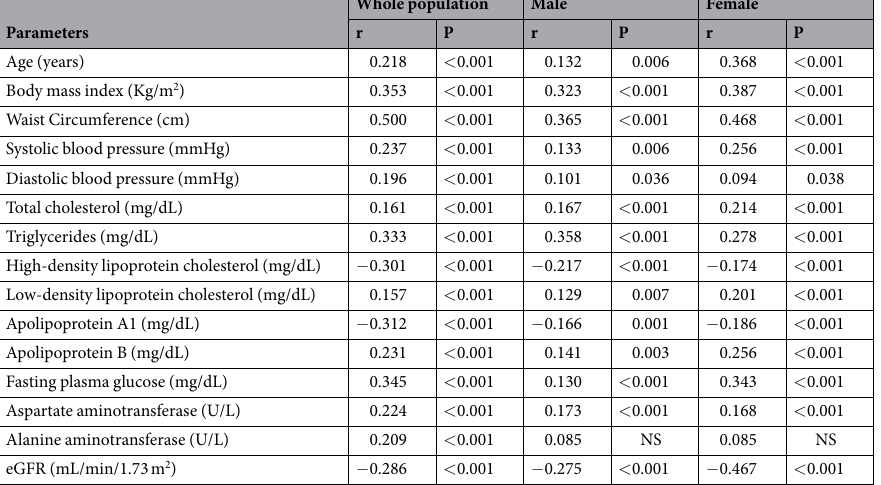
Table 2. Significant predictors of SUA in the whole population sample and by sex. eGFR, estimated glomerular filtration rate; NS, non significant.